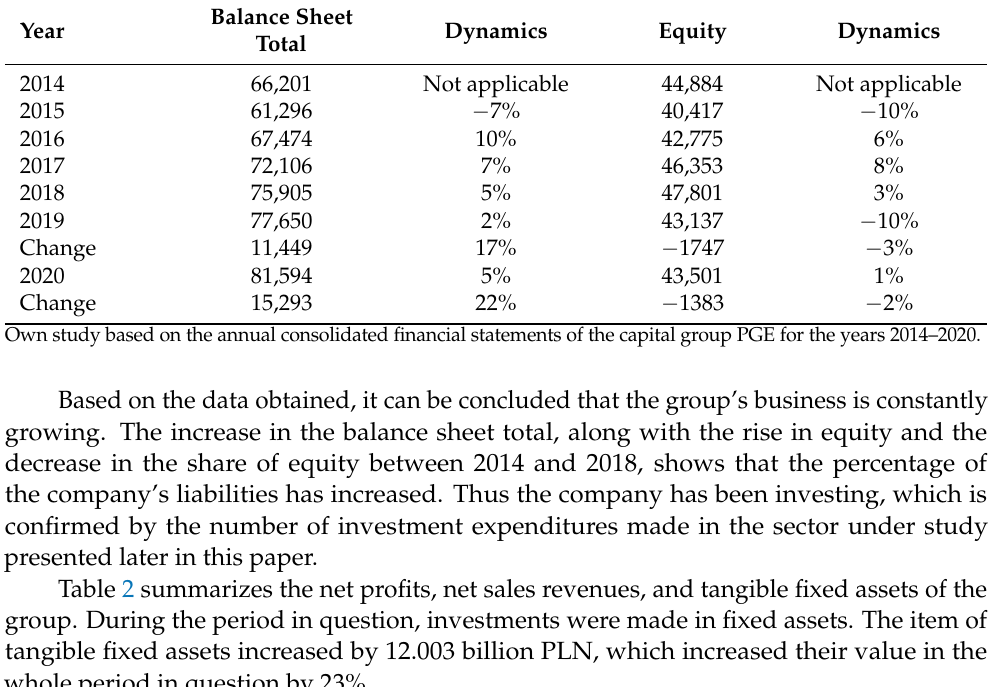
Table 2. Net profit, revenues and tangible fixed assets of the PGE Capital Group (in PLN million)